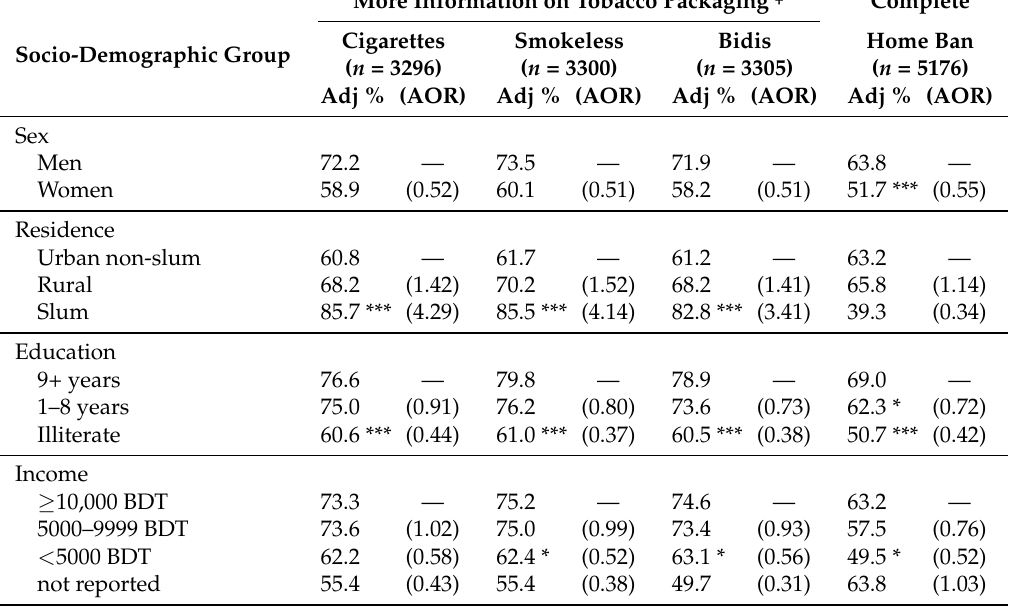
Table 5. Relationship between socio-demographic proxies of vulnerability and opinions about (a) tobacco packaging and (b) the presence of complete bans on smoking in the home estimated using logistic regression † . More Information on Tobacco Packaging ‡